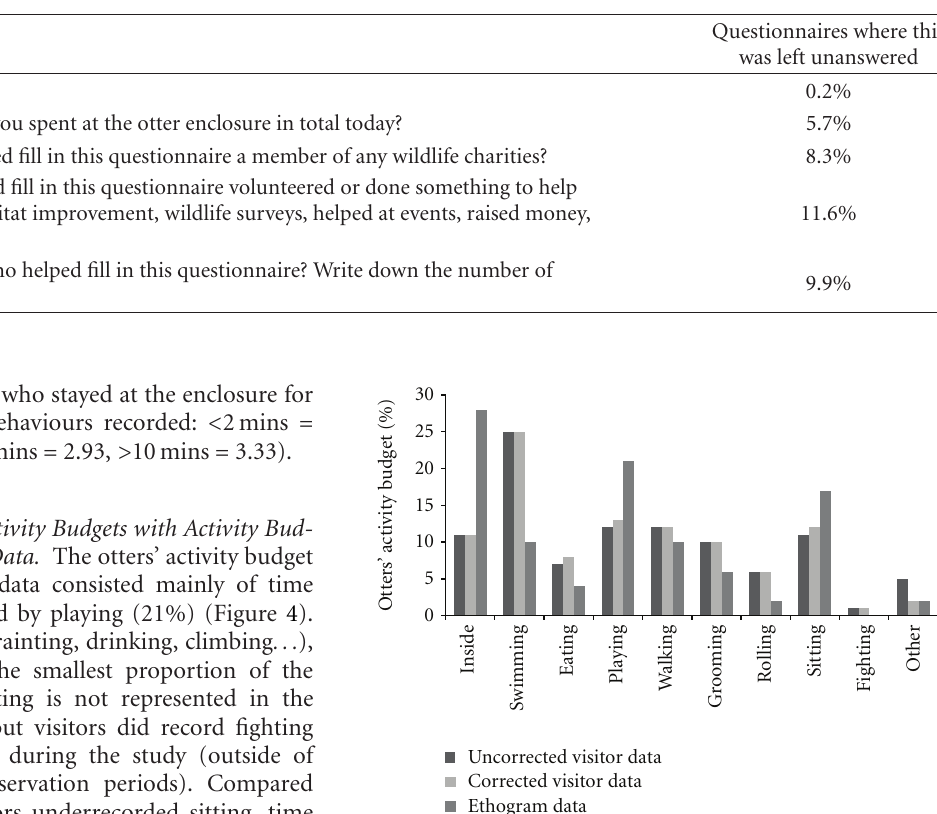
Table 3: Percentage of questions not answered in the otter behaviour questionnaire.